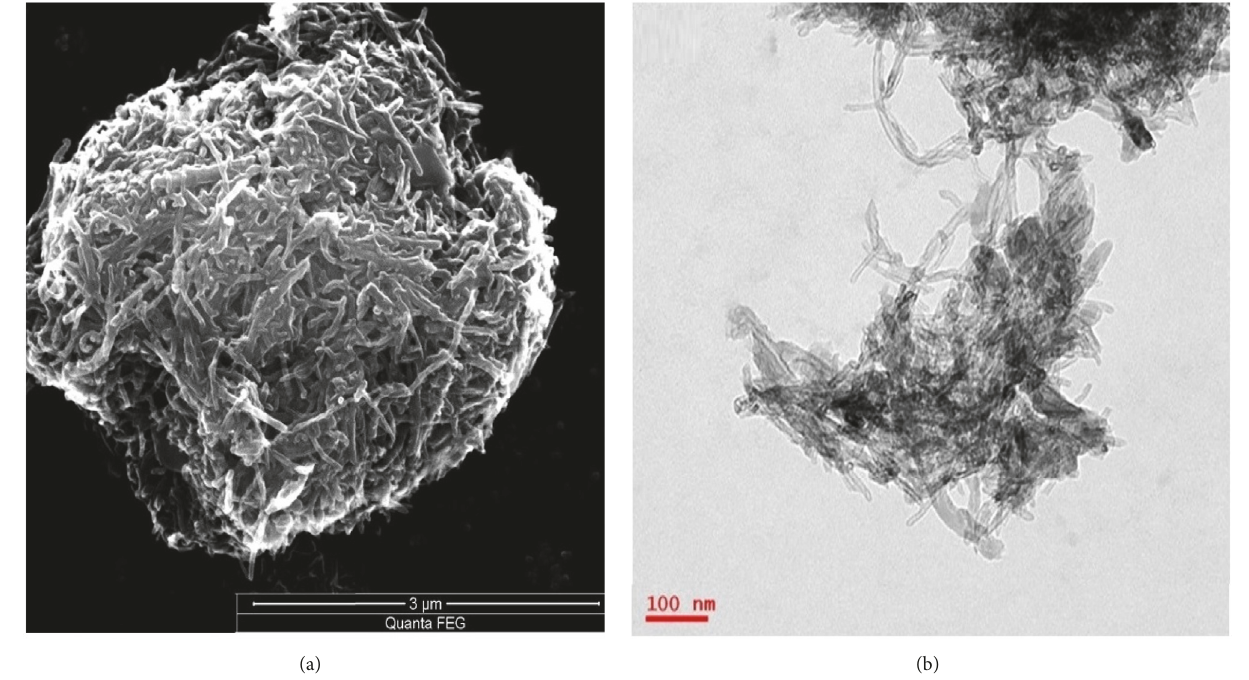
Figure 2: HRSEM images of 10-hour and 20-hour ball-milled MWCNTs. (a) 10-Hour ball-milled MWCNTs, (b) 20-hour ball-milled